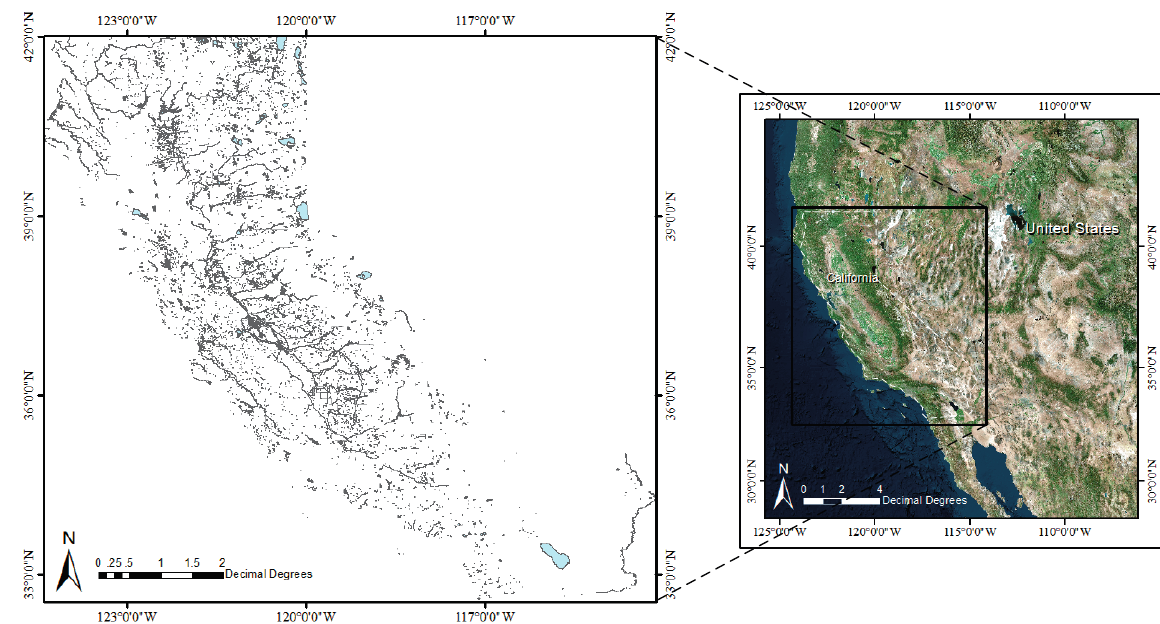
Figure 8. The water polygons in the study area